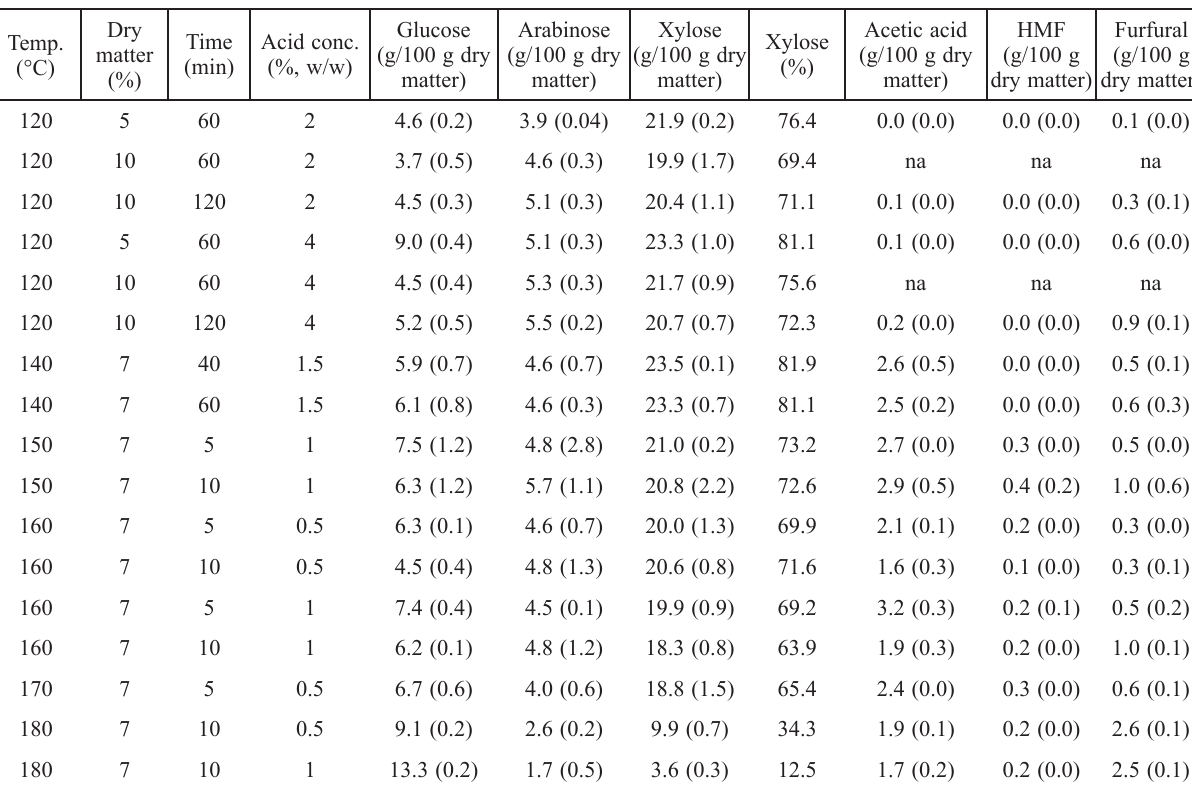
Table 2 – Reaction conditions, total sugar yields and degradation component yields of corn stover sulfuric acid hydrolysis. Standard deviations are calculated from duplicates. HMF: hydroxymethylfurfural. na: not analyzed. Temp.